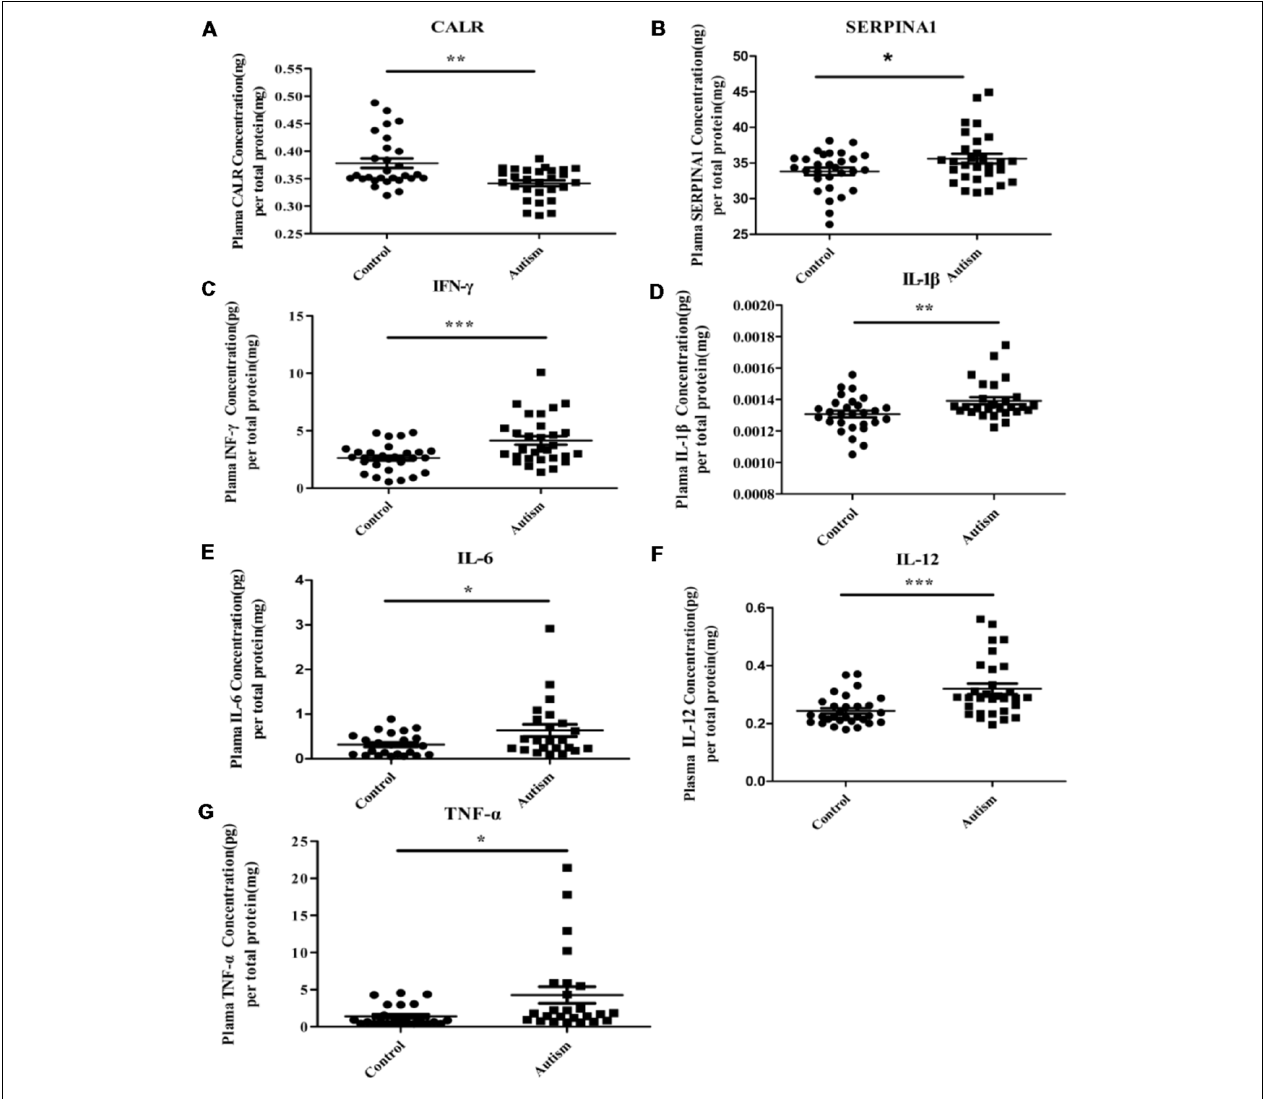
FIGURE 7 | Some of differentially expressed proteins were detected in PBMCs and pro-inflammatory cytokines were detected in plasma of children with autism by enzyme-linked immunosorbent assay (ELISA) analysis. (A) Calreticulin (CALR). Autism and control group, n = 28. (B) Alpha-1-antitrypsin (SERPINA1). Autism and control group, n = 29. (C) Interferon- γ (IFN- γ ). Autism and control group, n = 30. (D) Interleukin-1 β (IL-1 β ). Autism and control group, n = 28. (E) Interleukin-6 (IL-6). Autism and control group, n = 23. (F) IL-12. Autism and control group, n = 30. (G) Tumor necrosis factor- α (TNF- α ). Autism and control group, n = 25. The graphical results depict the mean ± SD, ∗ P < 0.05, ∗∗ P < 0.01, ∗∗∗ P < 0.001. CALR and SERPINA1 were detected in PBMCs and others pro-inflammatory cytokines were detected in